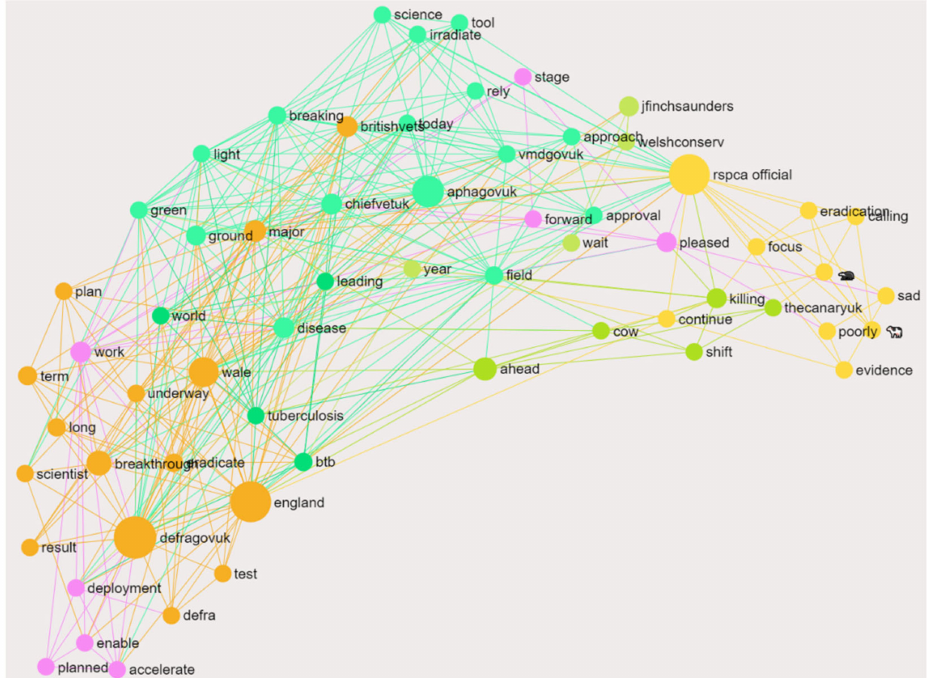
Figure 4. InfraNodus graphical visualization of the communication gap between the cattle vaccine favorable (CVF) for Announcement-2 and post-Announcement-1. Data present in Announcement-2 CVF, but absent in post-Announcement-1 CVF. Different colors represent different topical clusters that are connected, whilst lines show the connections between different words and clusters. Each word is represented by a node, with the node size changing depending on its level of influence on other words around it. For example, in this social network analysis, defragovuk was absent in Announcement-1, but present in Announcement-2 where it has a large orange node. This shows it is highly and diversely connected to other words and therefore has a greater overall influence on them and, upon detailed analysis, was found to influence the positive sentiment directed towards the bovine tuberculosis (bTB) cattle